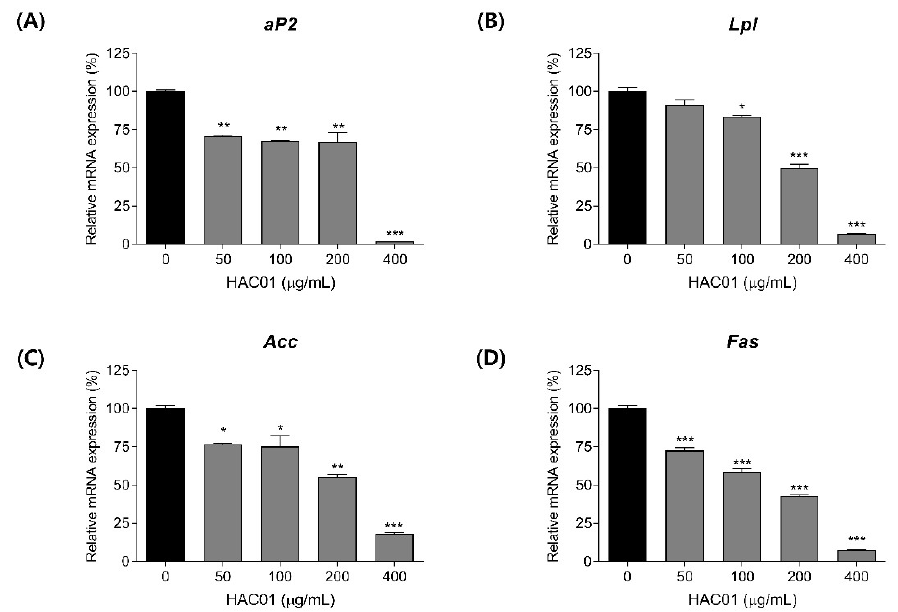
Figure 2. Effects of Lactobacillus plantarum HAC01 lysate on the mRNA expression levels of adipogenic and lipogenic factors in 3T3-L1 cells. Adipocyte differentiation was induced in the presence of L. plantarum HAC01 lysate for 7 d. mRNA expression levels of ( A ) aP2 , ( B ) Lpl , ( C ) Acc , and ( D ) Fas were quantified using qRT-PCR. aP2 , adipocyte protein 2; Lpl , lipoprotein lipase; Acc , acetyl-CoA carboxylase; Fas , fatty acid synthase. All results are presented as mean ± SD. * p < 0.01, ** p < 0.005, and *** p < 0.001 vs. 0 μg/mL.